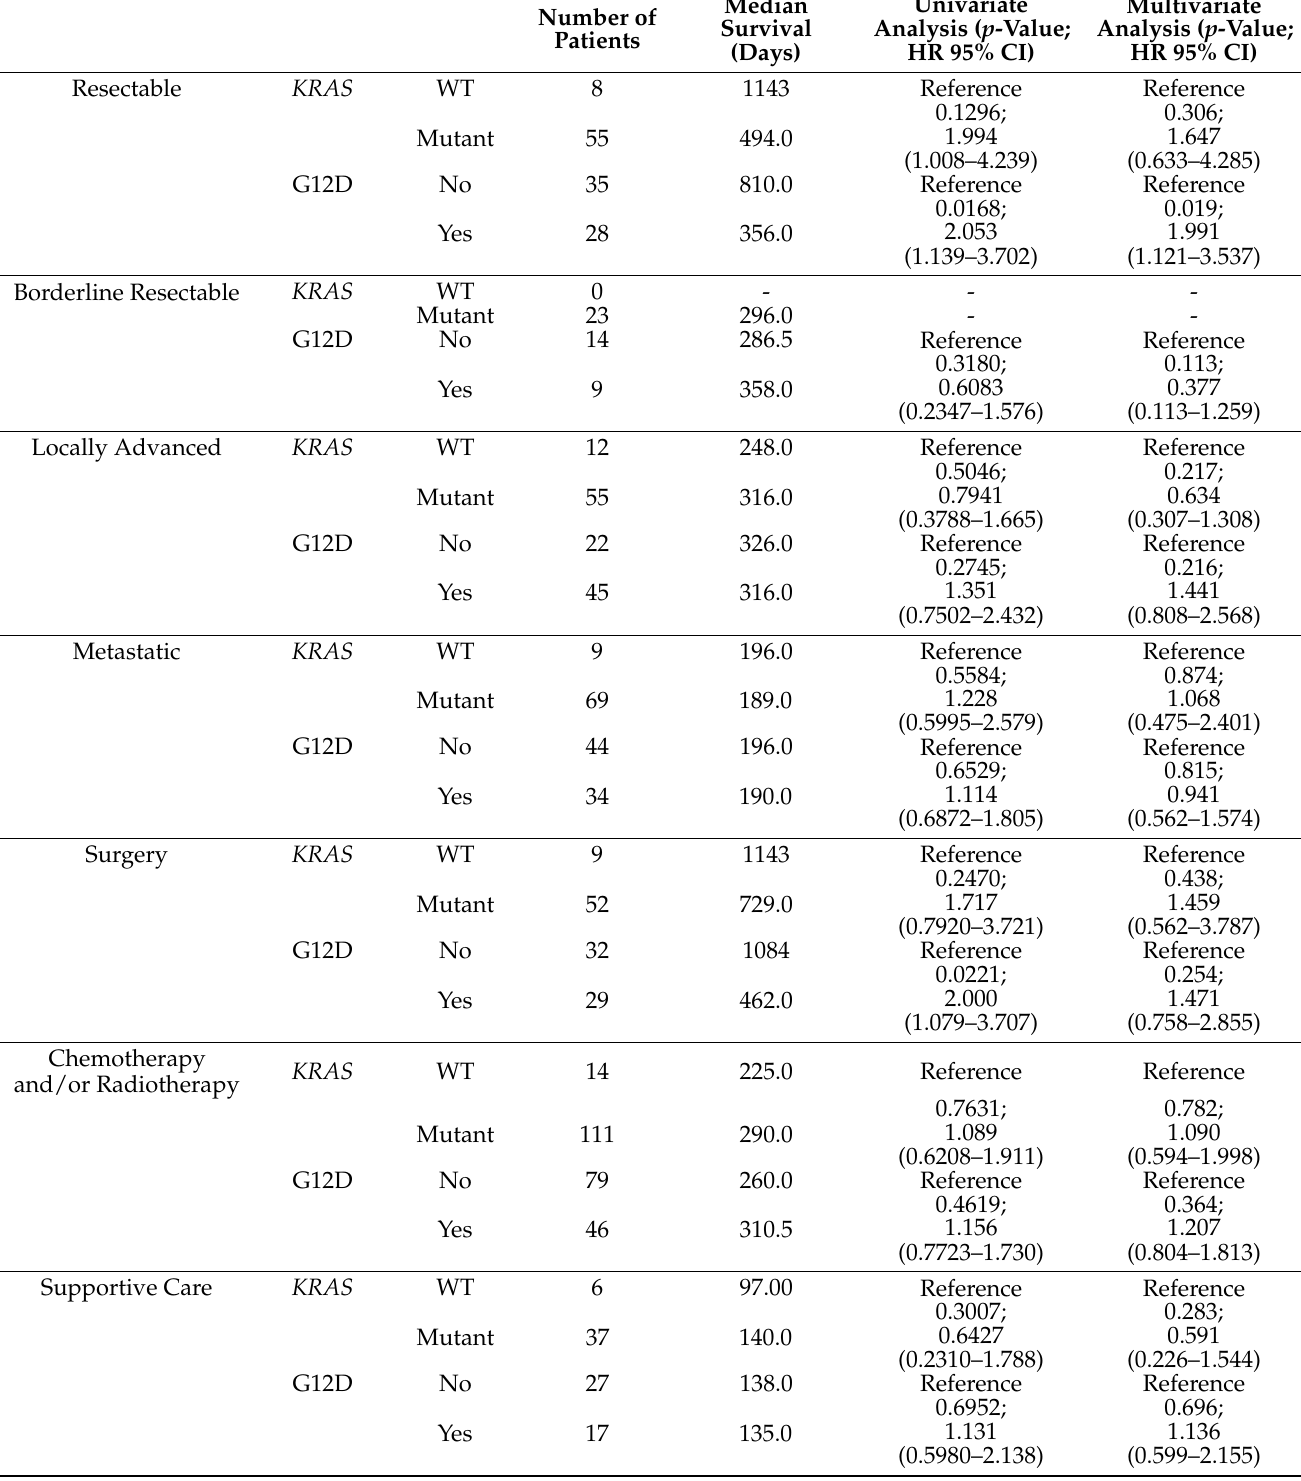
Table 6: Survival within stages and treatment groups. Median survival and significance displayed for each group. Univariate analysis performed using log-rank test; multivariate analysis performed using Cox